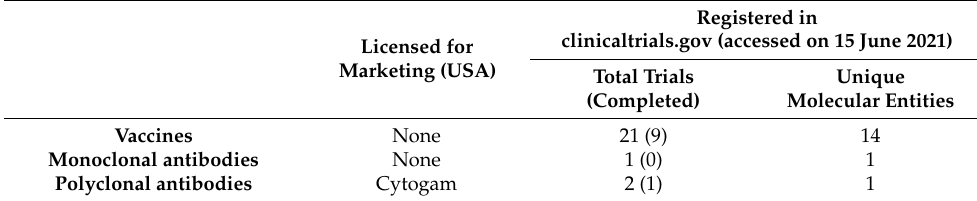
Table 1. Vaccines and Antibody Therapies for CMV